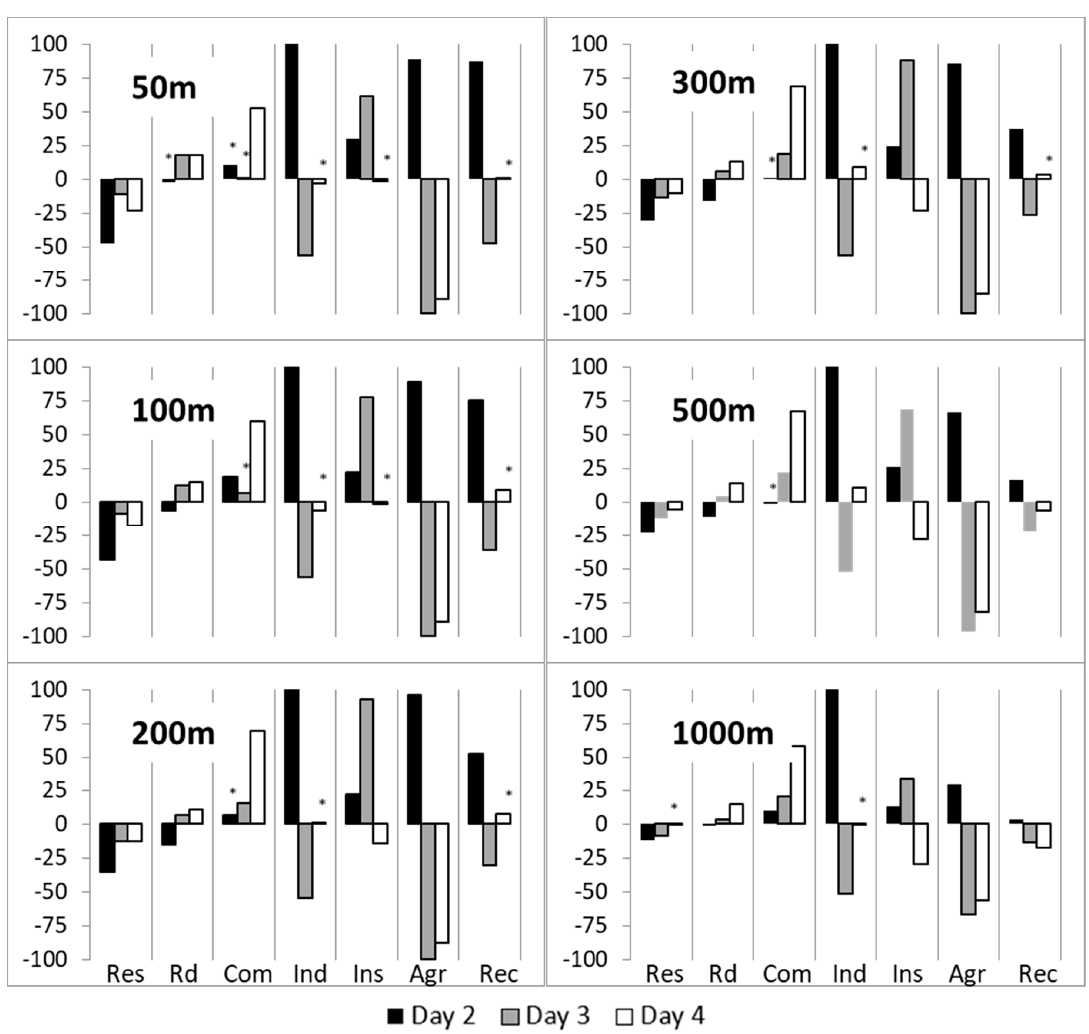
Figure 11. Percent change in land use predictor variables at different buffer distances between the 20% most heavily polluted segments of the cycled network and the remainder of the cycled path. * denotes an insignificant difference (two-tailed t -test, equal variances not assumed p > 0.05). Res = Residential, Rd = Road, Com = Commercial, Ind = Industrial, Ins = Institutional, Agr = Agriculture, and Rec = Recreational.